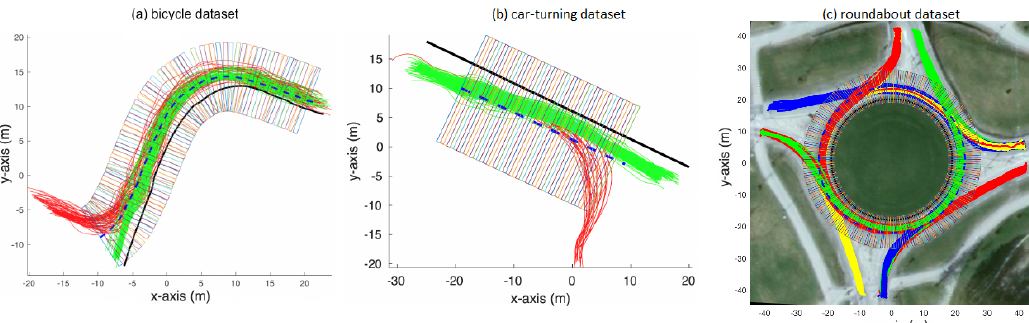
Figure 1. Trajectories and the discretisation grid for: ( a ) bicycle dataset; ( b ) car-turning dataset; and ( c ) roundabout dataset.